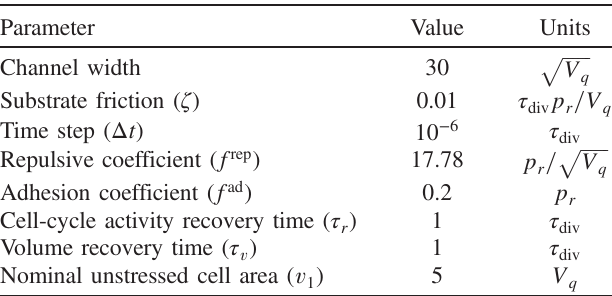
TABLE I. Standard cell parameters.